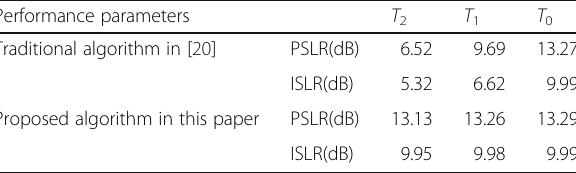
Table 2 Performance parameters in azimuth for case I Performance parameters